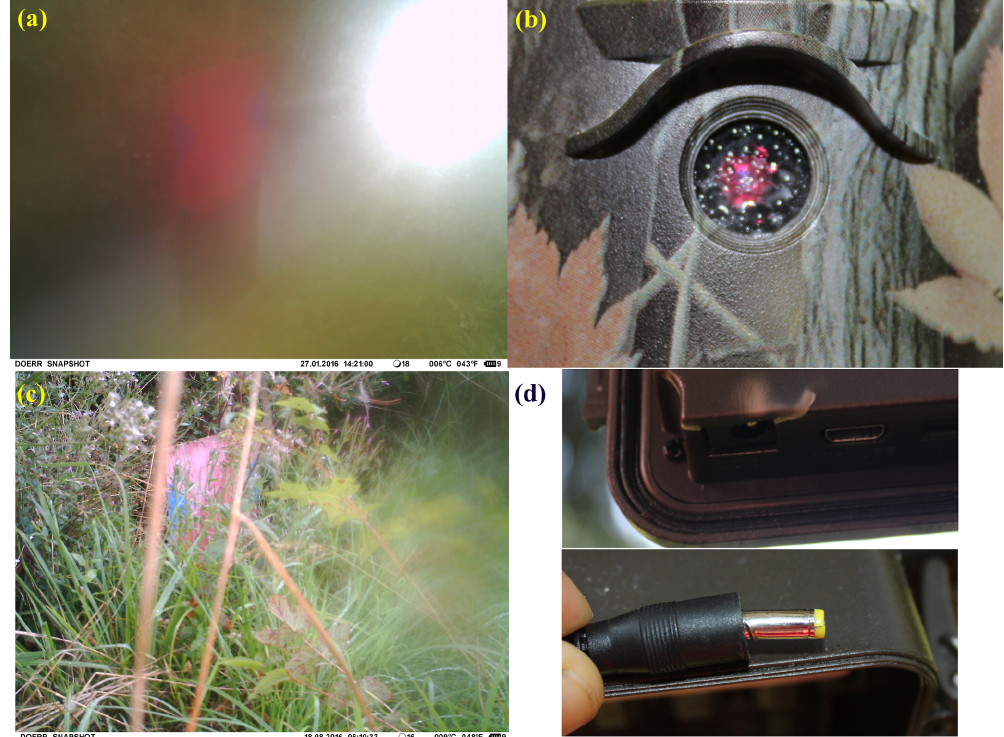
Figure 8. Sources of uncertainties and errors in the time-lapse imagery data: (a) reflections of sublight into the lens, (b) growth of vegetation between camera and stream, (c) damaged cable connection after attempted SD card theft or (d) by condensed water within the lens